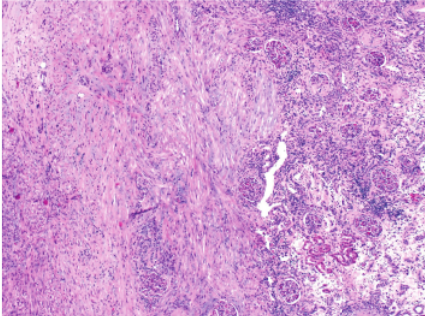
Figure 1: Computed tomography scan showing cross-section of the abdomen with a right-sided renal mass measuring 3.8 cm.